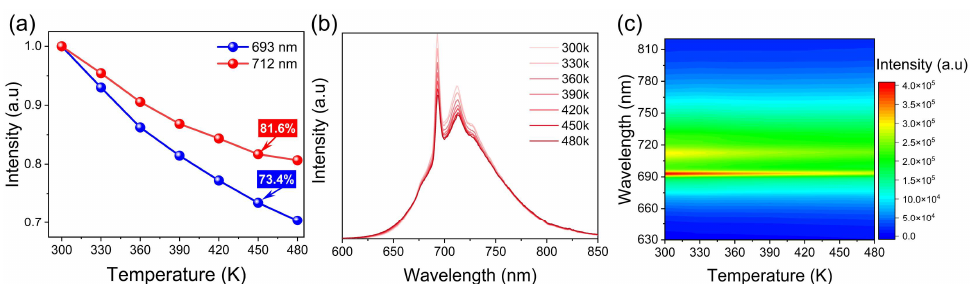
Figure 6. Emission intensities of 693 nm and 712 nm ( a ) and emission spectra; ( b,c ) of GAGG:0.1Cr 3+ , 0.01Dy 3+ dependent on temperatures.